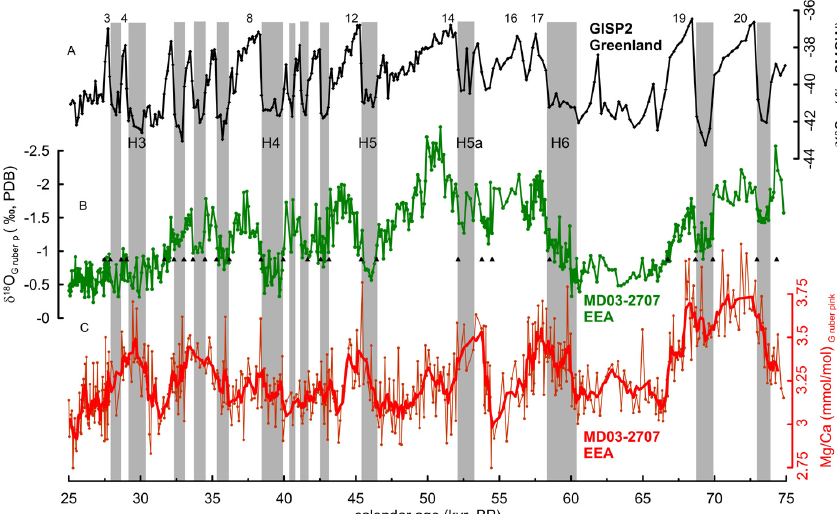
Fig. 4. (a) GISP2 δ 18 O ice record compared with the δ 18 O (Weldeab, 2012) (b) and Mg/Ca records (c) analyzed in G. ruber (pink). (c) Thin and bold red lines present individual Mg/Ca measurements and a 5-point running average, respectively. Triangles mark tie points used to align δ 18 O shifts in the MD03-2707 record (b) with the GISP2 δ 18 O ice record (a) . Vertical gray bars indicate stadials and Heinrich events. Numbers indicate